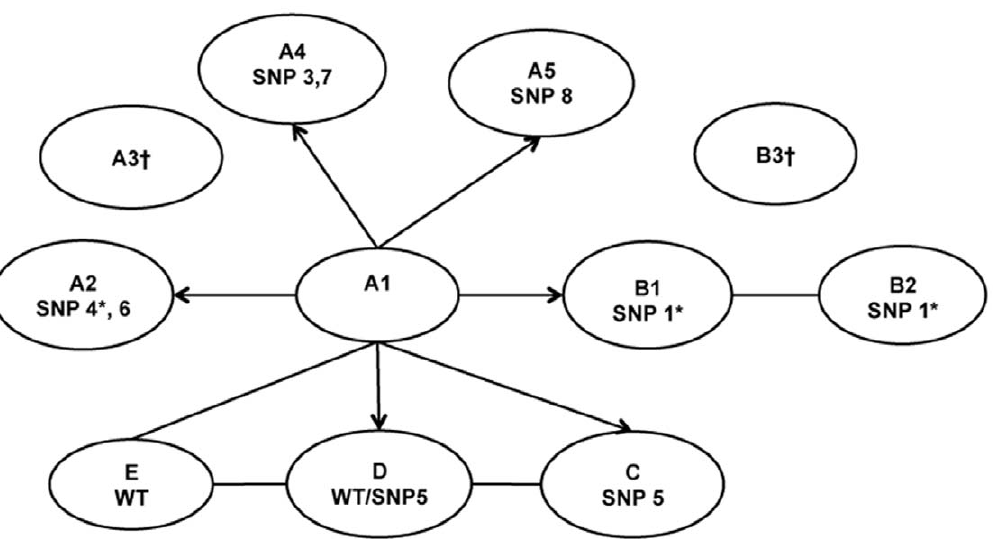
Figure 2. SNP-based network. The letters inside the circles correspond to the patients; SNP correspond to the number of the SNP observed in the M. tuberculosis isolate and described in Table 1; lines represent links based on the SNPs and arrows show the sequential SNP acquisition. WT refers to the genotype of A1. *Mutations predicted to affect the protein according to SIFT. { Culture negative or not performed.